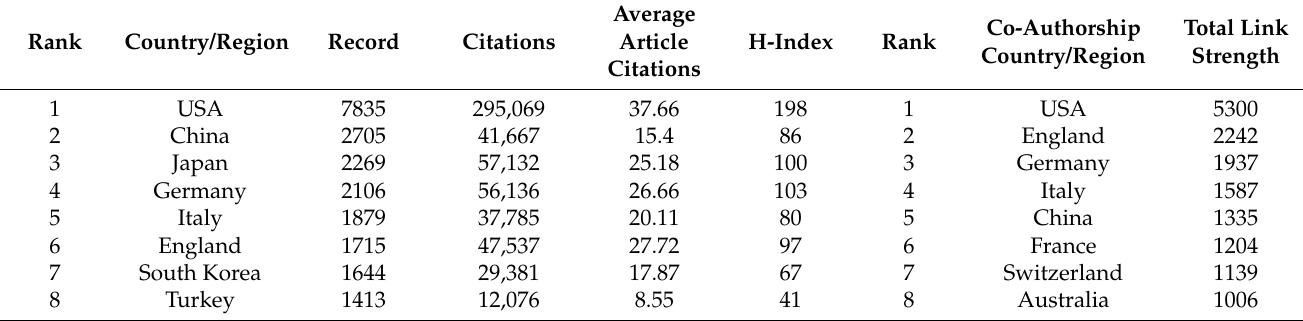
Table 2. The top 10 most productive and collaborative